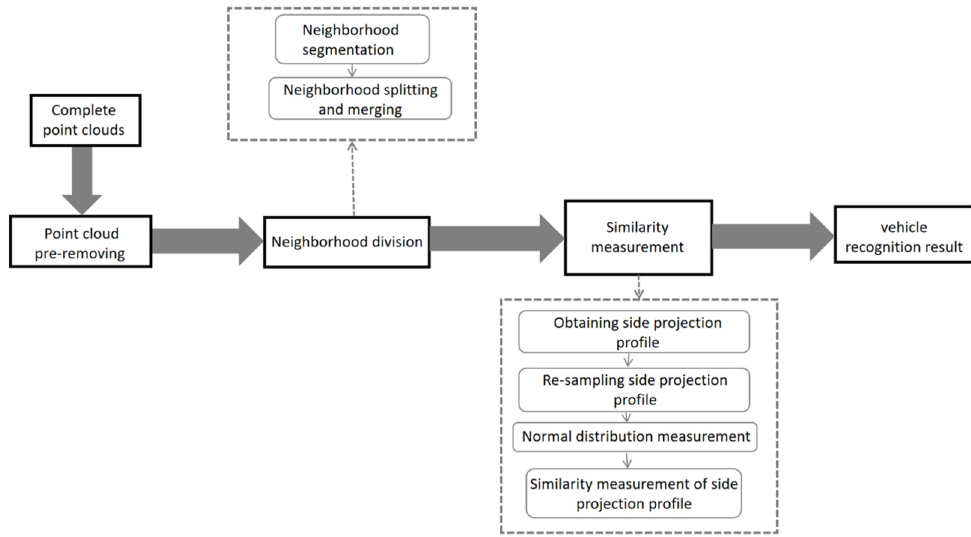
Figure 1. The workflow of vehicle recognition based on region growth of relative tension and similarity measurement of side projection profile of vehicle body.